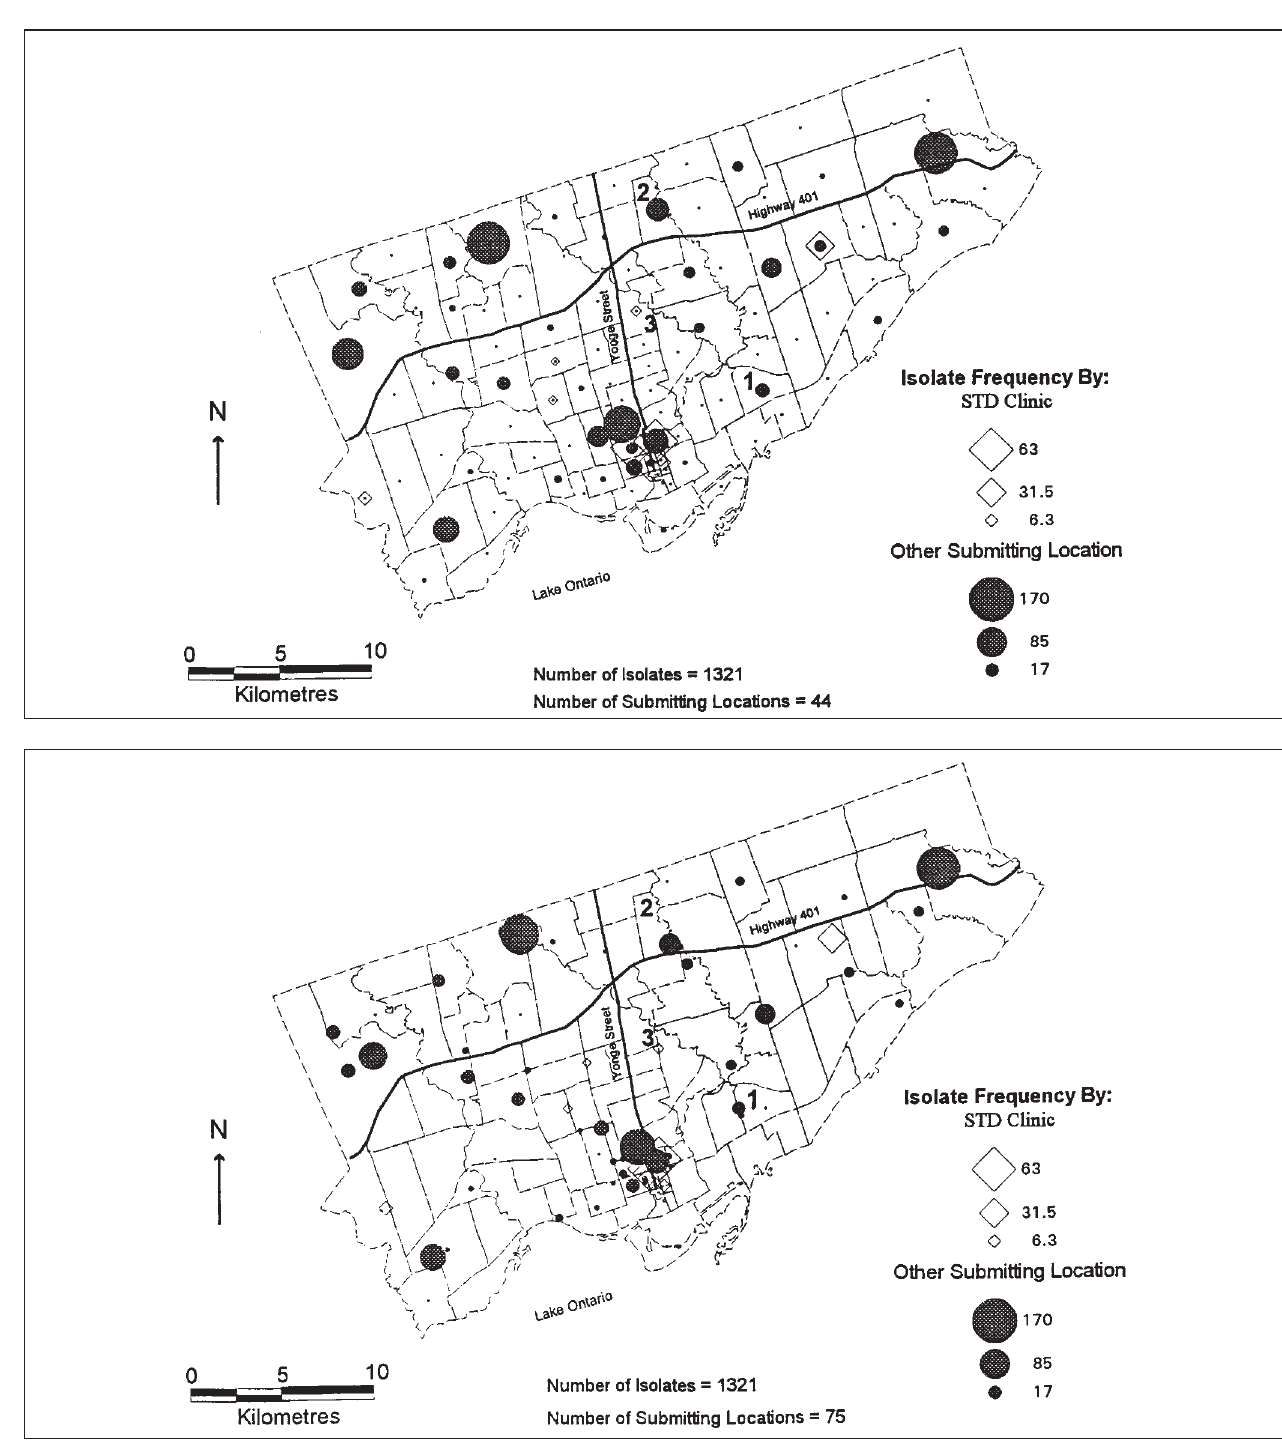
Figure 2) Top Spatial distribution of penicillinase-producing isolates of Neisseria gonorrhoeae (PPNG) and tetracycline-resistant N gonorrhoeae (TRNG) by submitting locations in Metropolitan Toronto, 1988 to 1992, using three-digit postal codes. Bottom Spatial distribution of PPNG and TRNG by submitting locations in Metropolitan Toronto, 1988 to 1992, using six-digit postal codes. Symbols (circles and boxes) are proportionally graduated according to the number of isolates reported at each submitting location. Forward sortation area boundaries are included as a frame of reference. STD Sexually transmitted